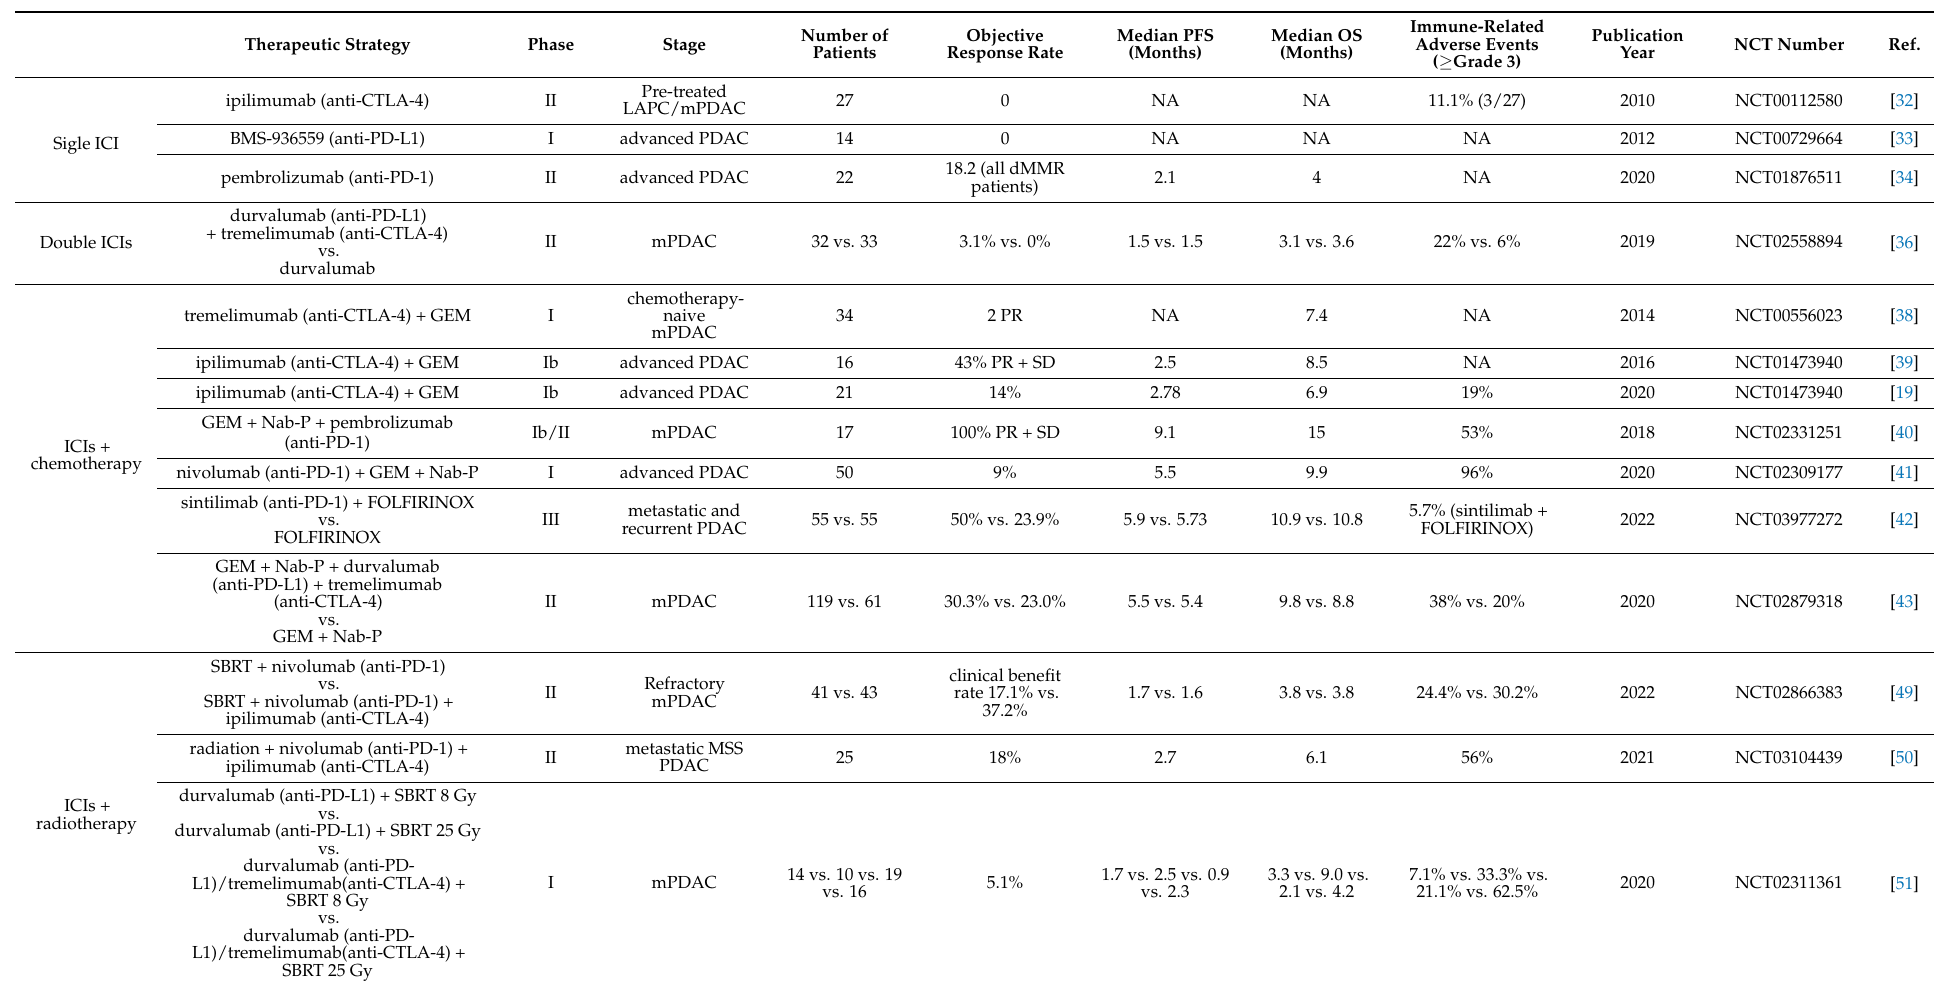
Table 1. Published clinical trials of ICIs in